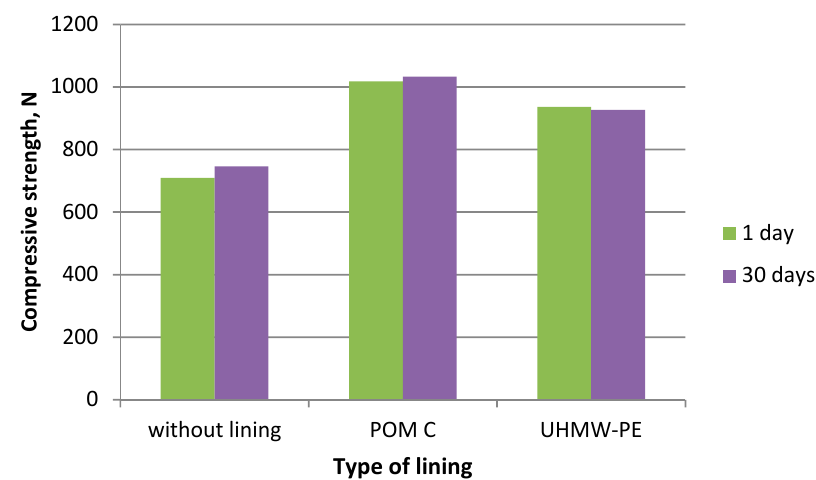
Figure 9. Compressive strength of briquettes made of Mixture 2 (fertiliser).